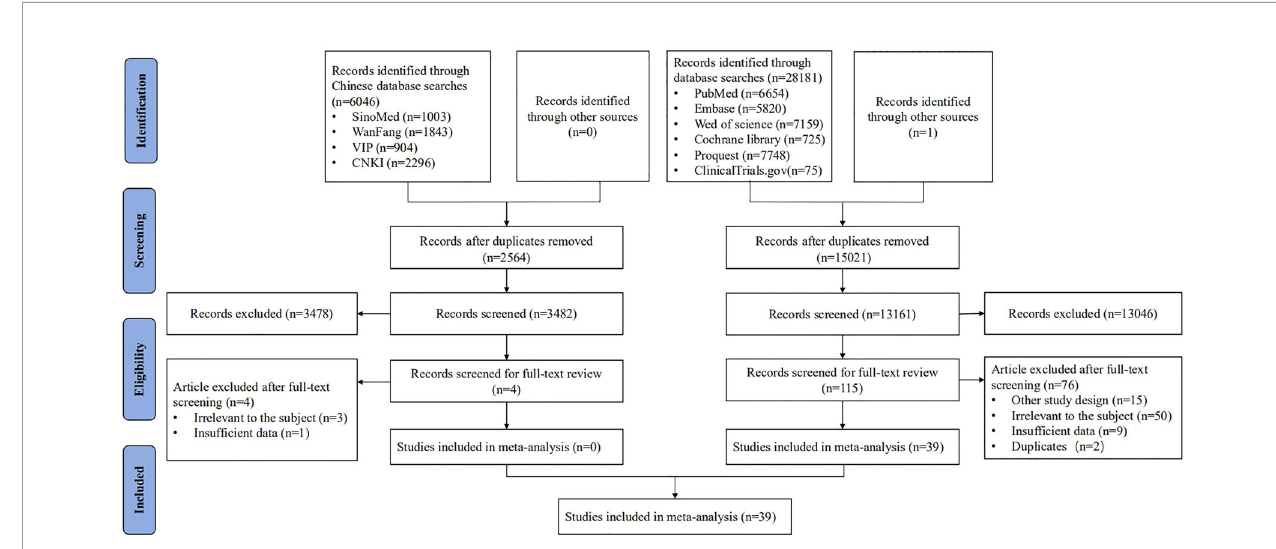
FIGURE 1 | Flowchart of the study